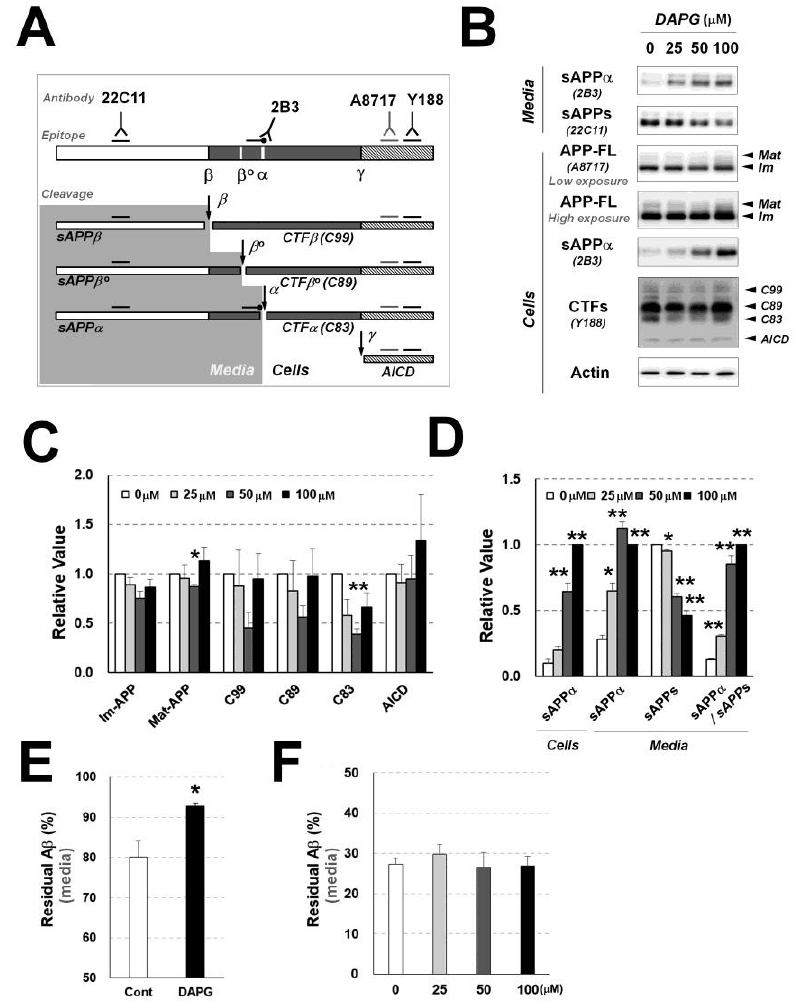
Figure 3. Examination of DAPG-mediated regulation of A β production and degradation or clearance in 293sw cells. ( A ) Schematic illustration of APP processing and antibodies detecting the cleaved products. Full-length APP (APP-FL) can be cleaved into soluble APP α (sAPP α ) and CTF α (C83) by α -secretase, soluble APP β (APP β ) and CTF β (C99) by β -secretase, or soluble APP β ’ (APP β ’) and CTF β ’ (C89) by β -secretase. C99 and C89 can be cleaved into APP intracellular domain